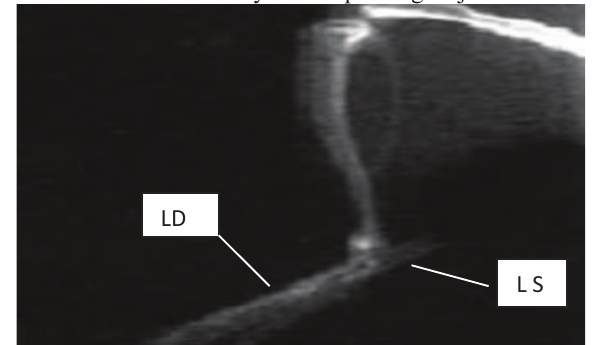
Fig-6: Prophylactic Group 6 Methalonic extract of Cassia fistula 250mg/kg treated rats showing mild swelling with less deformity of interphalangeal joints.